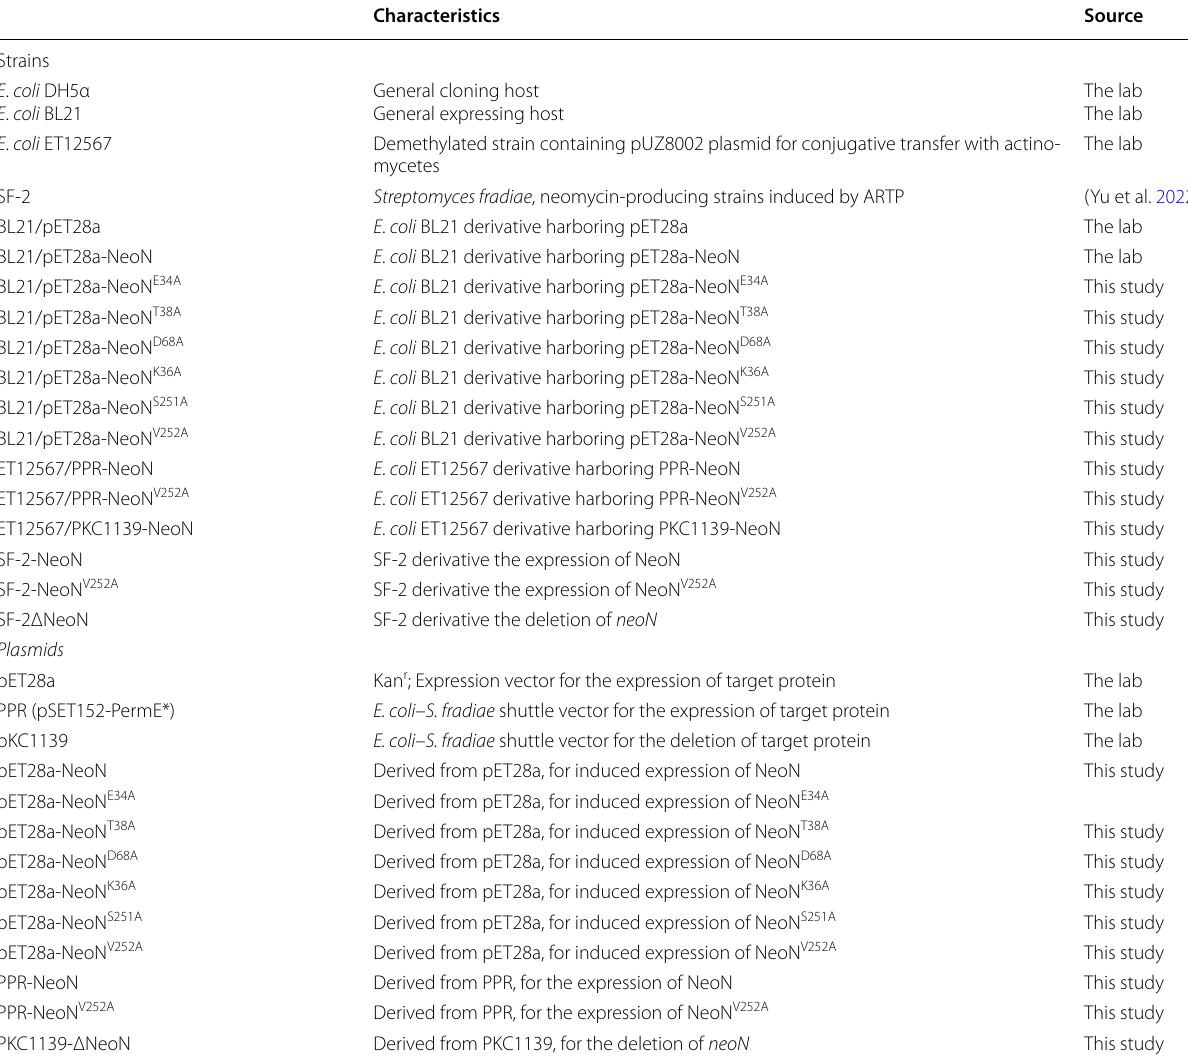
Table 1 Strains and plasmids used in this study